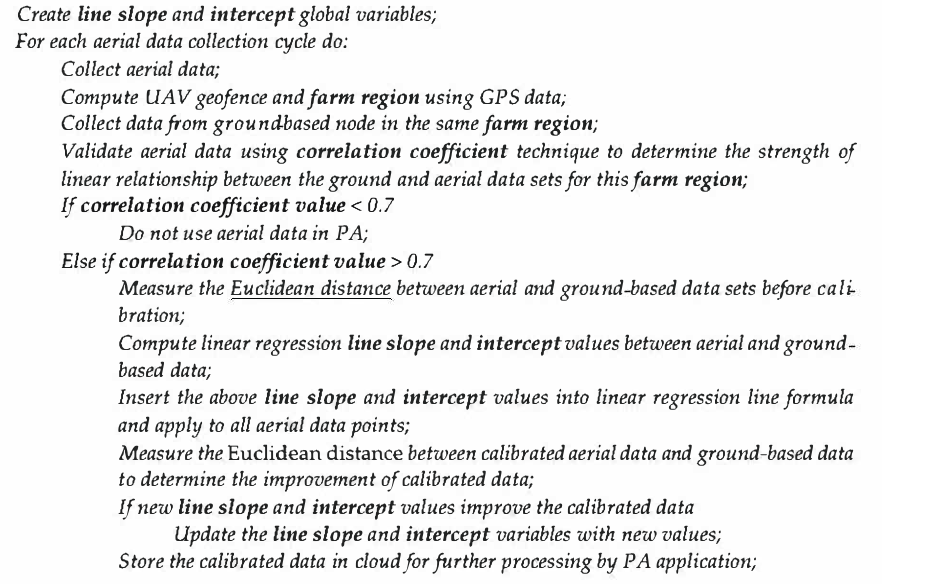
Algorithm 1 HSP validation and calibration